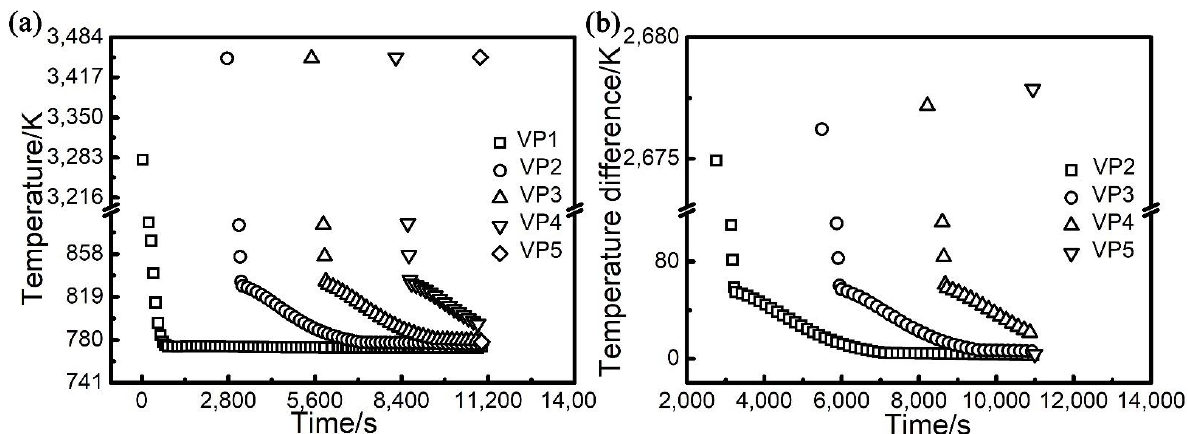
Figure 4. Evolution of peak temperature ( a ) and temperature difference ( b ) with time at different points along the building direction of the studied sample shown in Figure 1.